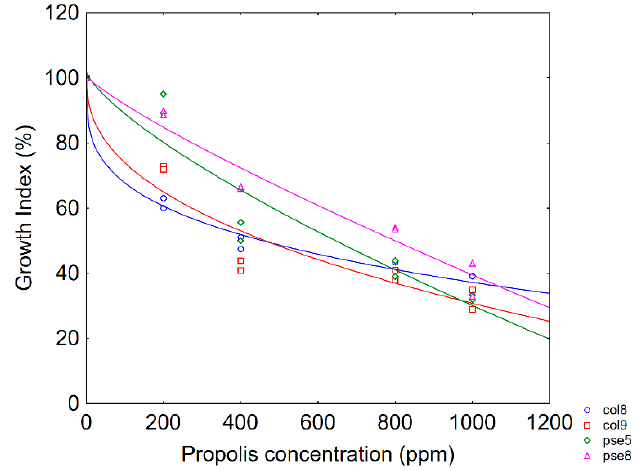
Figure 1. Dose response profile (Growth Index vs. propolis concentration) for pseudomonads and enterobacteria after 48 h. The lines represent the best fitting of data through Weibull model. col8, H. alvei ; col9, Enterobacter spp.; pse5, Ps. fluorescens ; pse8, Ps. putida . Micro-dilution approach for low-level inoculum (3 log cfu/mL).